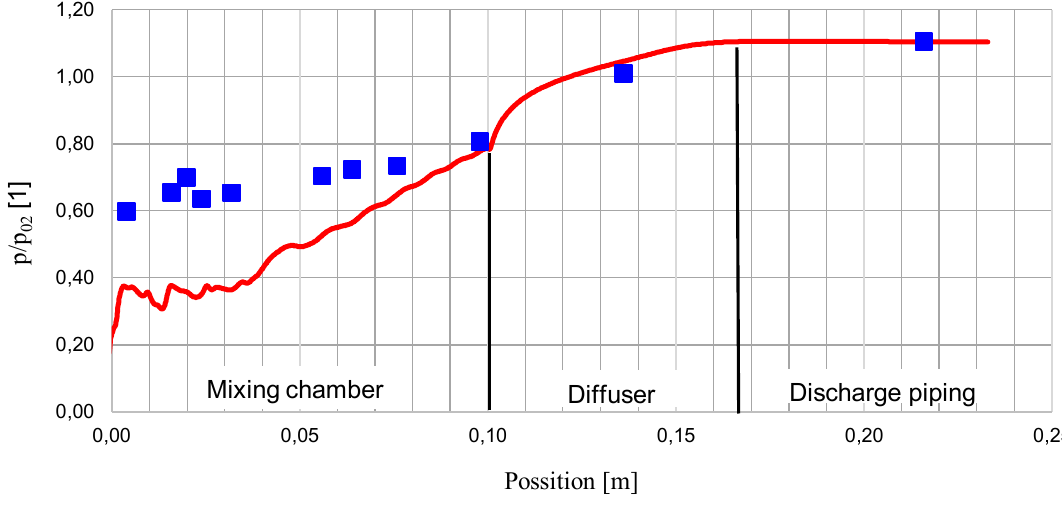
Fig. 12. Static pressure distribution, CFD (red line) and experiment (blue points) for NP 2 mm and 𝑝 4